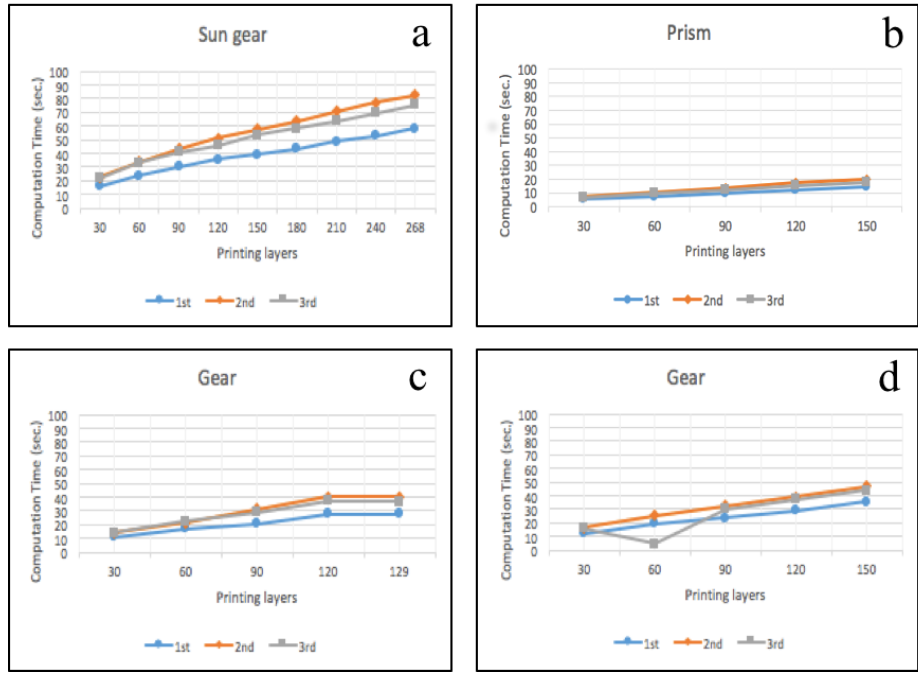
Figure 19. Error detection—Horizontal magnitude: the computation time of normal printing state for ( a ) sun gear; ( b ) Prism; ( c ) gear; and ( d ) t55gear. Failure Printing State